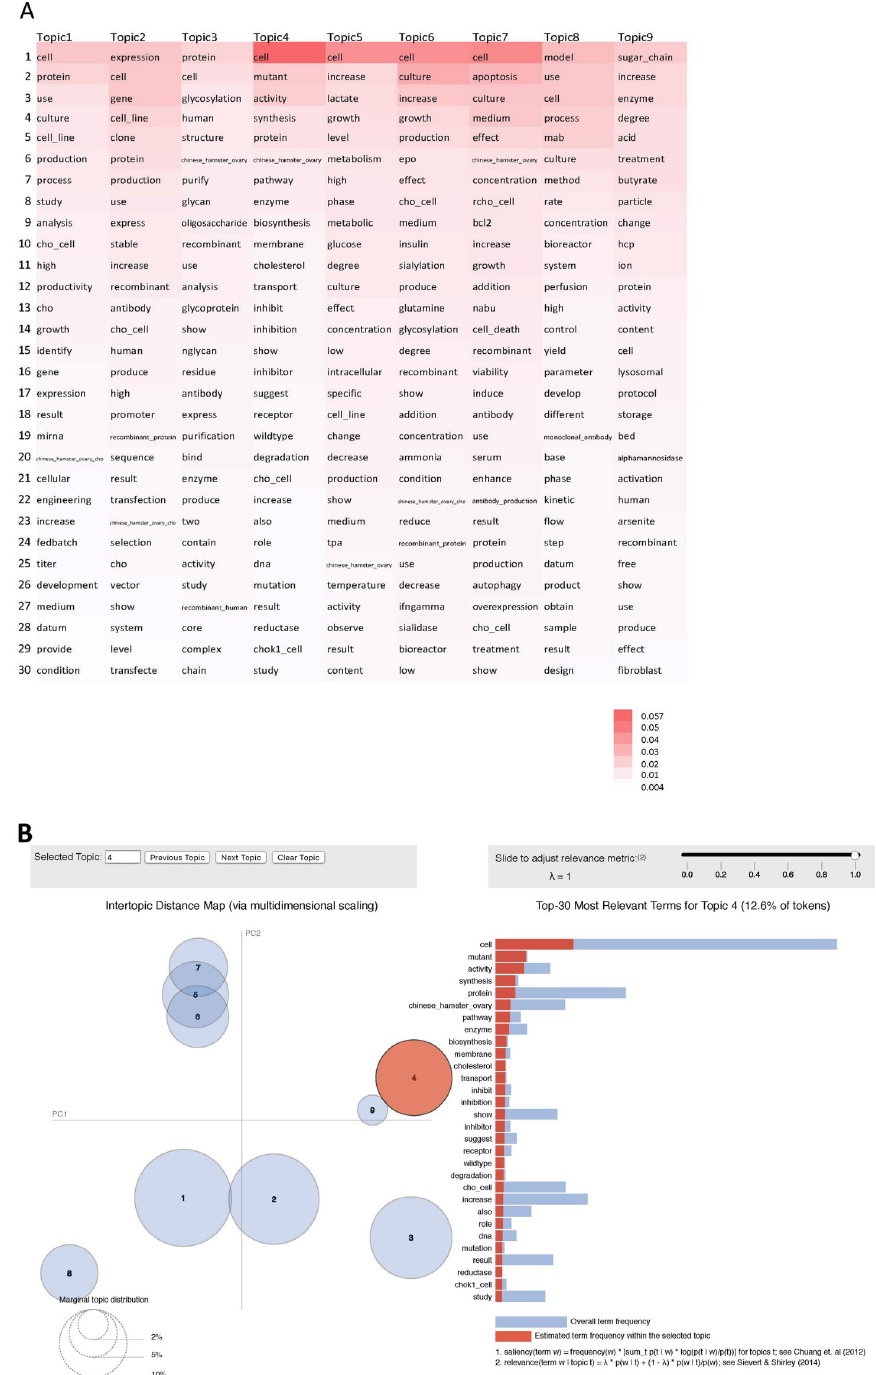
Fig 4. LDA topics with term probability. (A) The top 30 most frequent terms from nine LDA topics with weights. (B) Visualization of topic modeling results using pyLDAvis. Left shows semantic topic space, where each circle is a single topic and its size represents its importance in the model. The proximity between two circles reflects the semantic similarity of their concepts. Right shows Top-30 most salient terms for Topic-4. The terms (red bars) are in descending order of probability, and the blue bars show the terms’ frequency over whole corpus (i.e., a pair of overlaid bars represent both the corpus-wide frequency of a given term as well as the topic-specific frequency of the term). For a given term, when the red bar is almost the same length as the blue bar, it means it is a salient term almost exclusive to the topic.